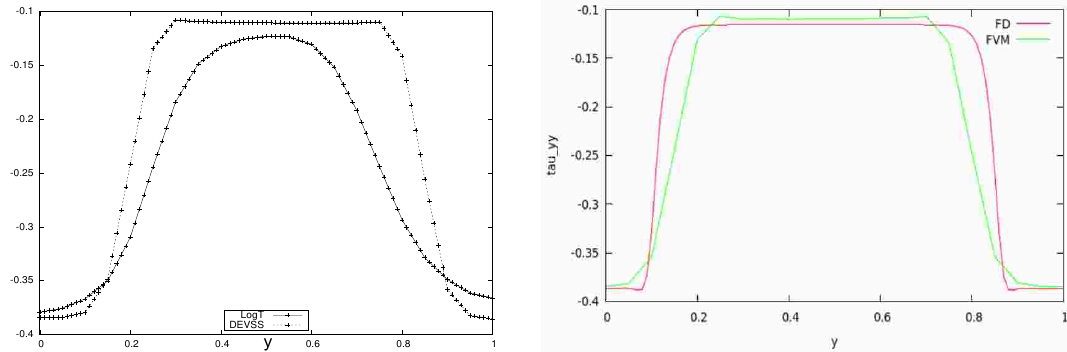
Figure 5. Normal stress profile ( τ yy = σ pyy ) for We = 2, η S = 0.05, η P = 0.95, ξ = 0.8, and Re = 1 for the Johnson-Segalman model (compared with reference [24] (RHS)).